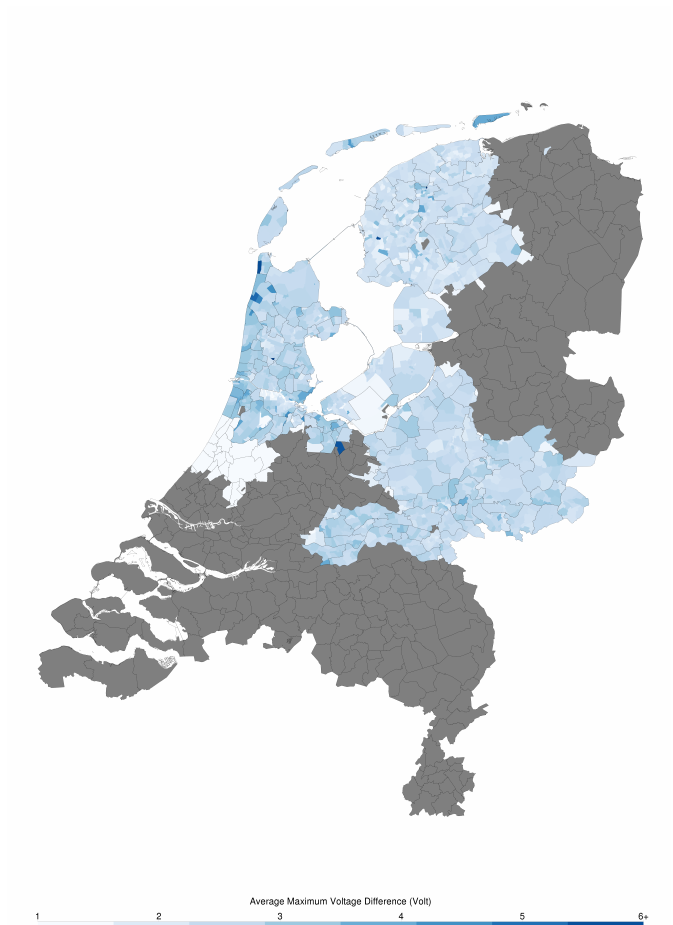
Figure 18. The difference between the highest and lowest voltage within the 90% confidence interval. It is a measure for the local variability between